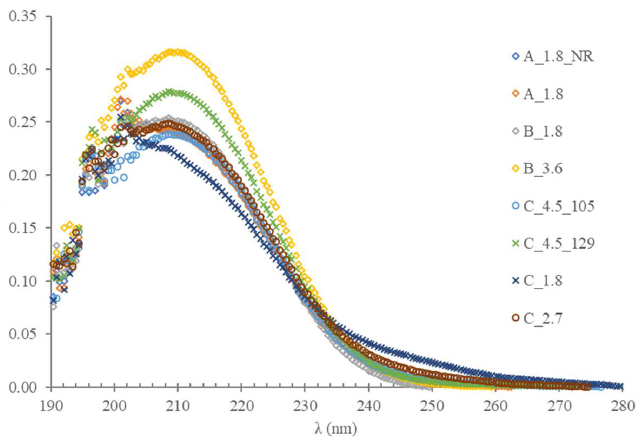
Figure 2. The spectra of citrate or buffered citrate solutions obtained from the tubes of different producers prepared in HCl medium and recorded in a 1-cm cuvette against the HCl blank.